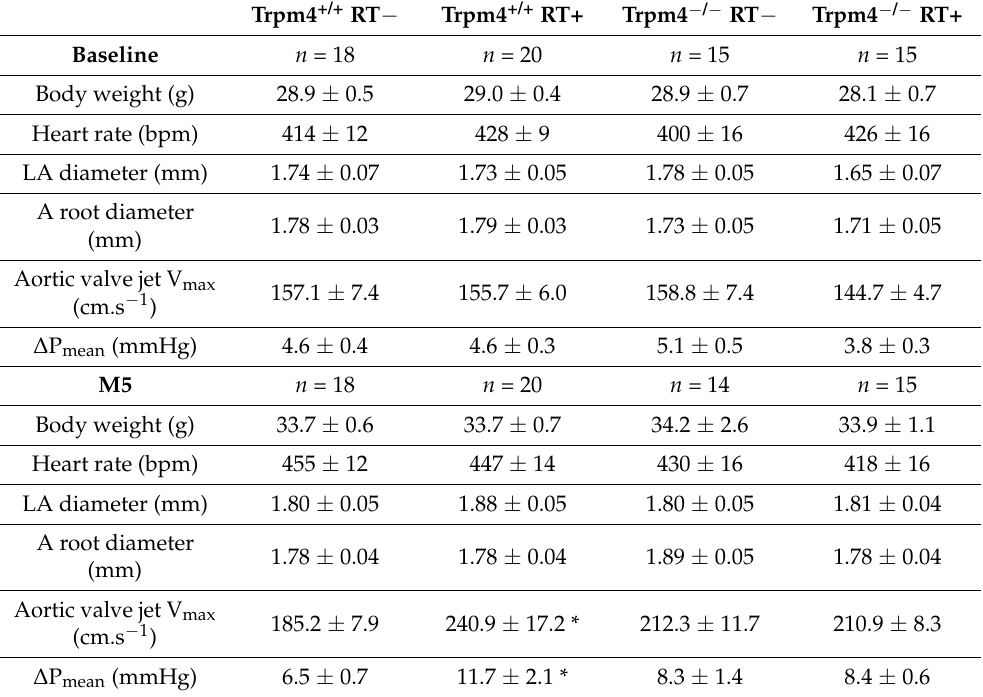
Table 1. Echocardiographic findings. Transthoracic echocardiography parameters in 4-month-old mice at baseline (before irradiation) and 5 months after irradiation (M5). Animals were randomly allocated to radiation treatment (RT+) or not (RT − ). Data are mean ± S.E.M. * statistically different from +/+ RT − . LA: left atrium; A: aorta; Vmax: maximal velocity; ∆ Pmean: mean transaortic pressure